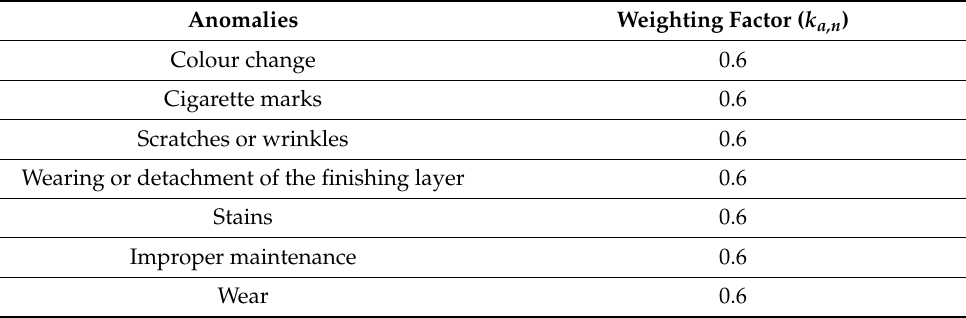
Table 5. Weighting factors associated to aesthetics anomalies.